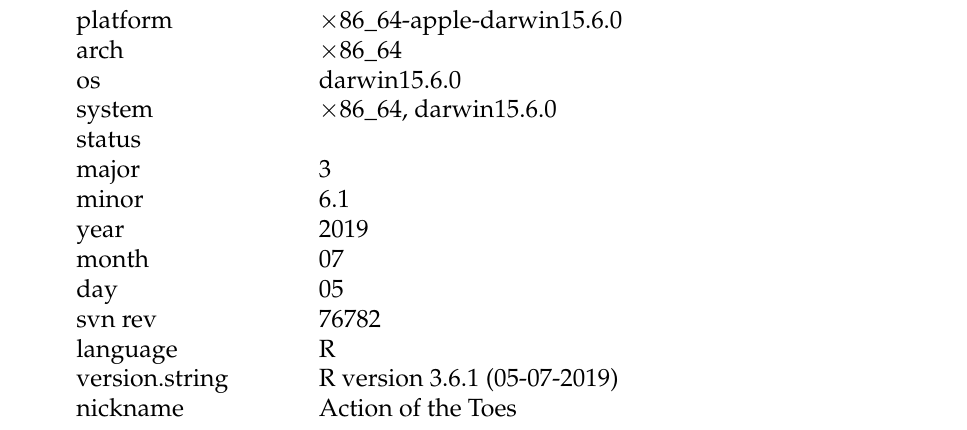
Table 3. System and R Studio specification details at the time of testing subjected R